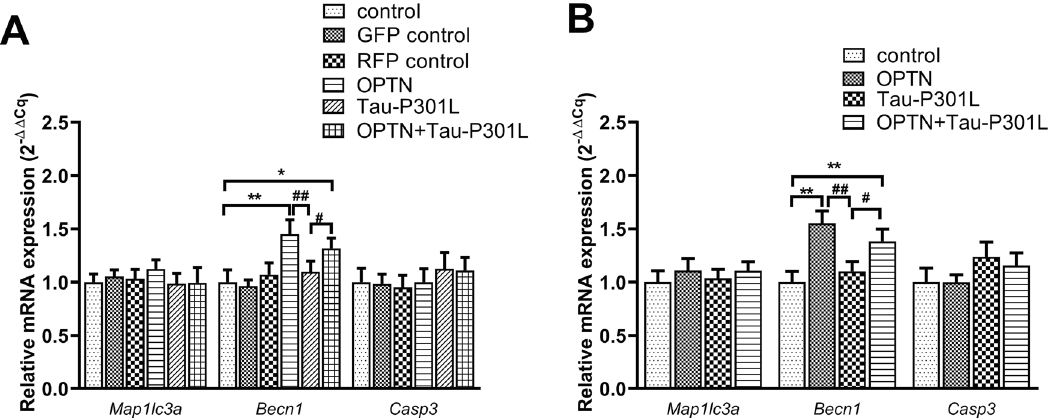
Fig. 5 OPTN regulates the mRNA level of autophagy- and apoptosis-associated genes in cells and mice brain tissues infected AAV. Actb was used as the reference gene. A Neuronal cell line HT22. B The brain tissue of Kunming mice. Data are presented as the mean ± SD (cell line: n = 6; mice: n = 10). * P < 0.05, ** P < 0.01 compared with control; # P < 0.05, ## P < 0.01 compared with Tau-P301L . GFP green fl uorescent protein, RFP red fl uorescent